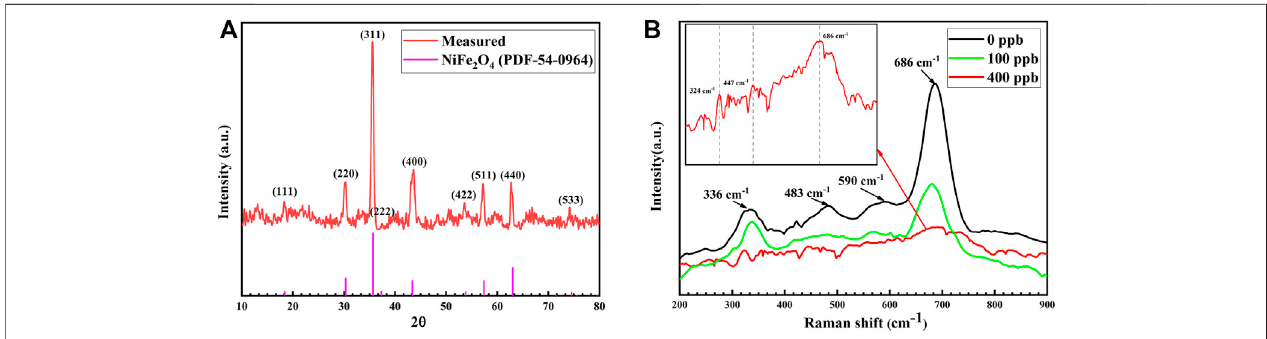
FIGURE 3 | (A) GIXRD of the oxide fi lm on 304SS after exposure to the Zn-free solution (B) Raman spectrum of the oxide fi lm on 304SS after exposure to the solutions with 0, 100 and 400 ppb Zn.